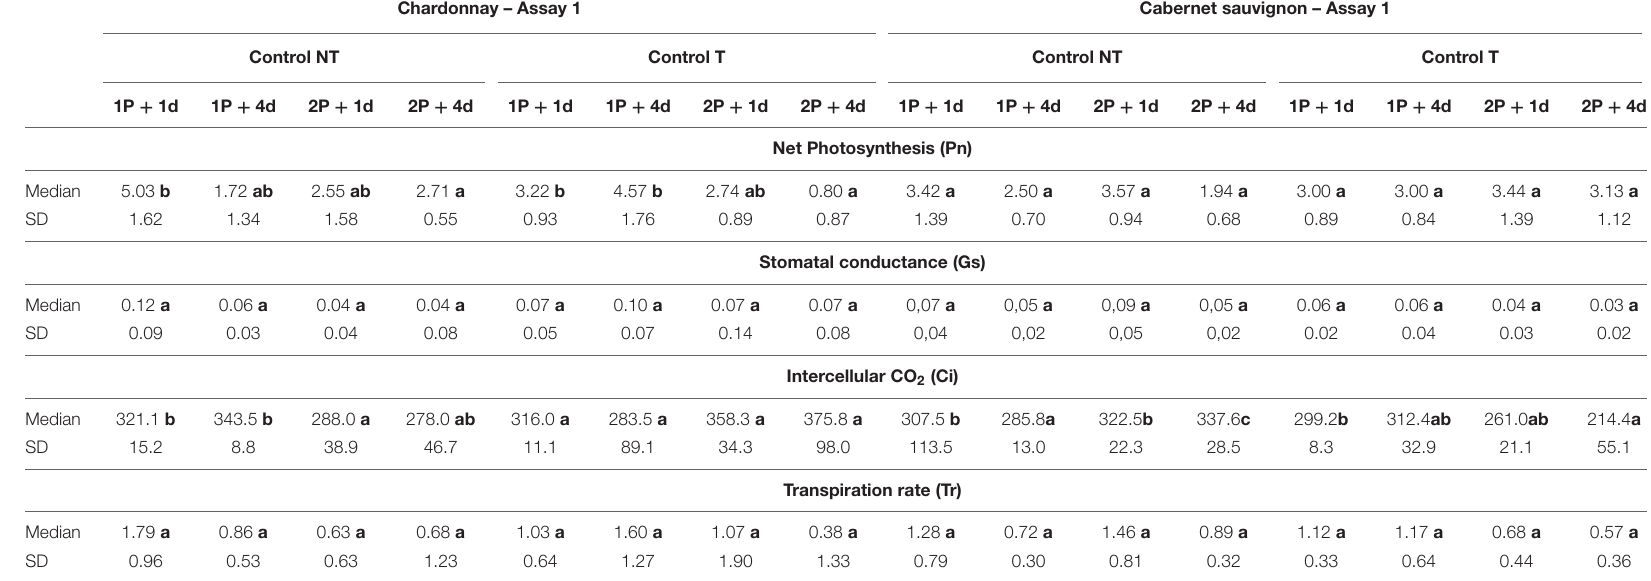
TABLE 4 | Evolution of photosynthetic parameters (Pn, Gs, Ci, and Tr) recorded during Assay 1 one ( + 1 d) and four ( + 4 d) days after each post infection treatment on non-inoculated grapevines of “Chardonnay” and “Cabernet